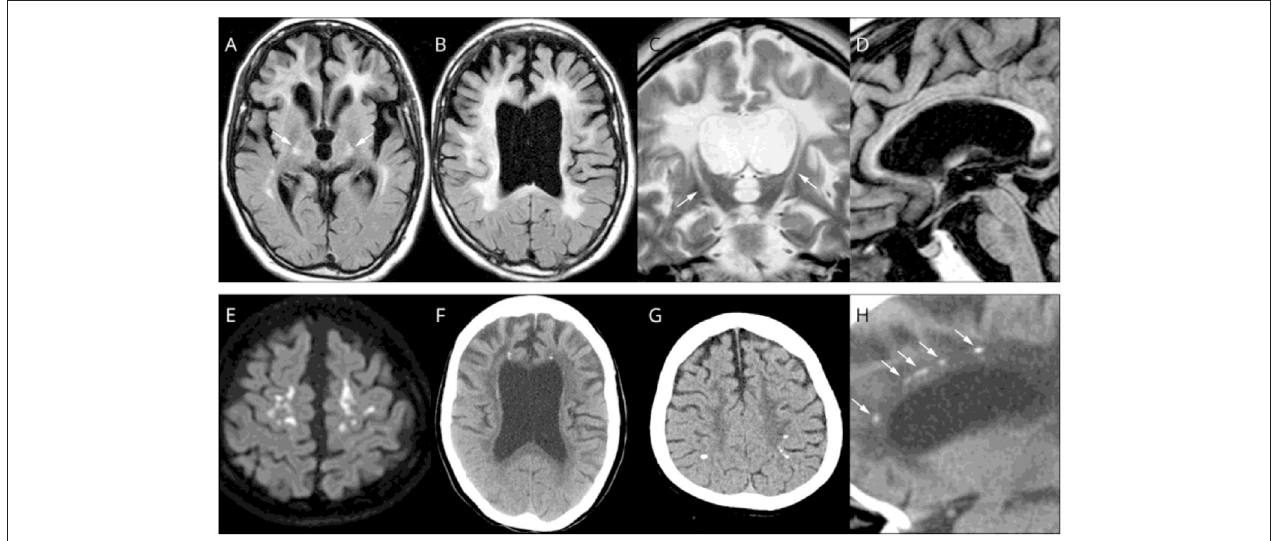
FIGURE 3 | Brain magnetic resonance imaging (MRI)/computed tomography (CT) findings from cases of Colony-Stimulating Factor-1 Receptor ( CSF1R )-related leukoencephalopathy. (A–D,F,H) A 44-year-old woman with CSF1R p.G589R. (E) A 27-year-old woman with CSF1R c.2442 + 5G > A. (G) A 31-year-old woman with CSF1R p.A652P . (A,B) , Bilateral diffuse white matter hyperintensity with pyramidal tract involvement (arrows in A ), cortical atrophy, and enlarged lateral ventricles on fluid-attenuated inversion recovery MRI. (C) Longitudinal pyramidal tract involvement (arrows) on coronal T2-weighted image. (D) Thinning of the corpus callosum with hyperintensity on sagittal fluid-attenuated inversion recovery image. (E) Hyperintensity lesions in the subcortical white matter on diffusion-weighted image. (F) Small calcifications located bilaterally near the anterior horns of the lateral ventricles on brain CT image. (G) Calcifications in parietal subcortical white matter. (H) Stepping-stone appearance of calcifications (arrows) in the frontal pericallosal region on sagittal CT image. Reprinted with permission from